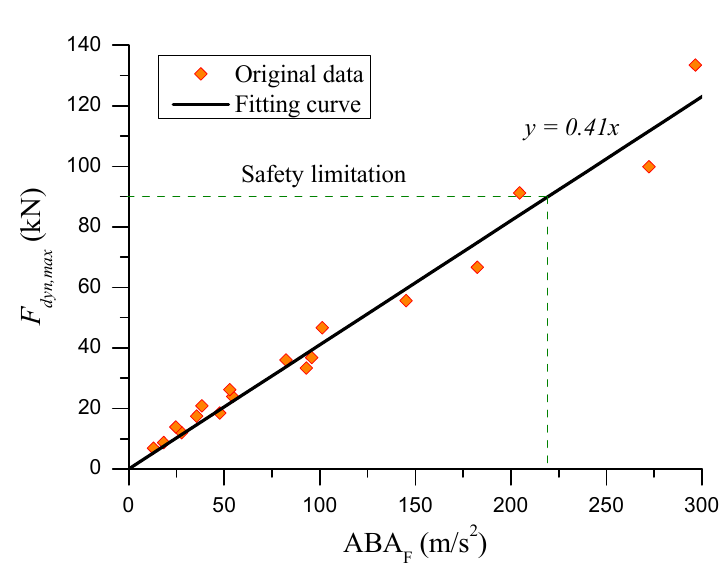
Figure 14. The relationship between ABA F and F dyn,max .